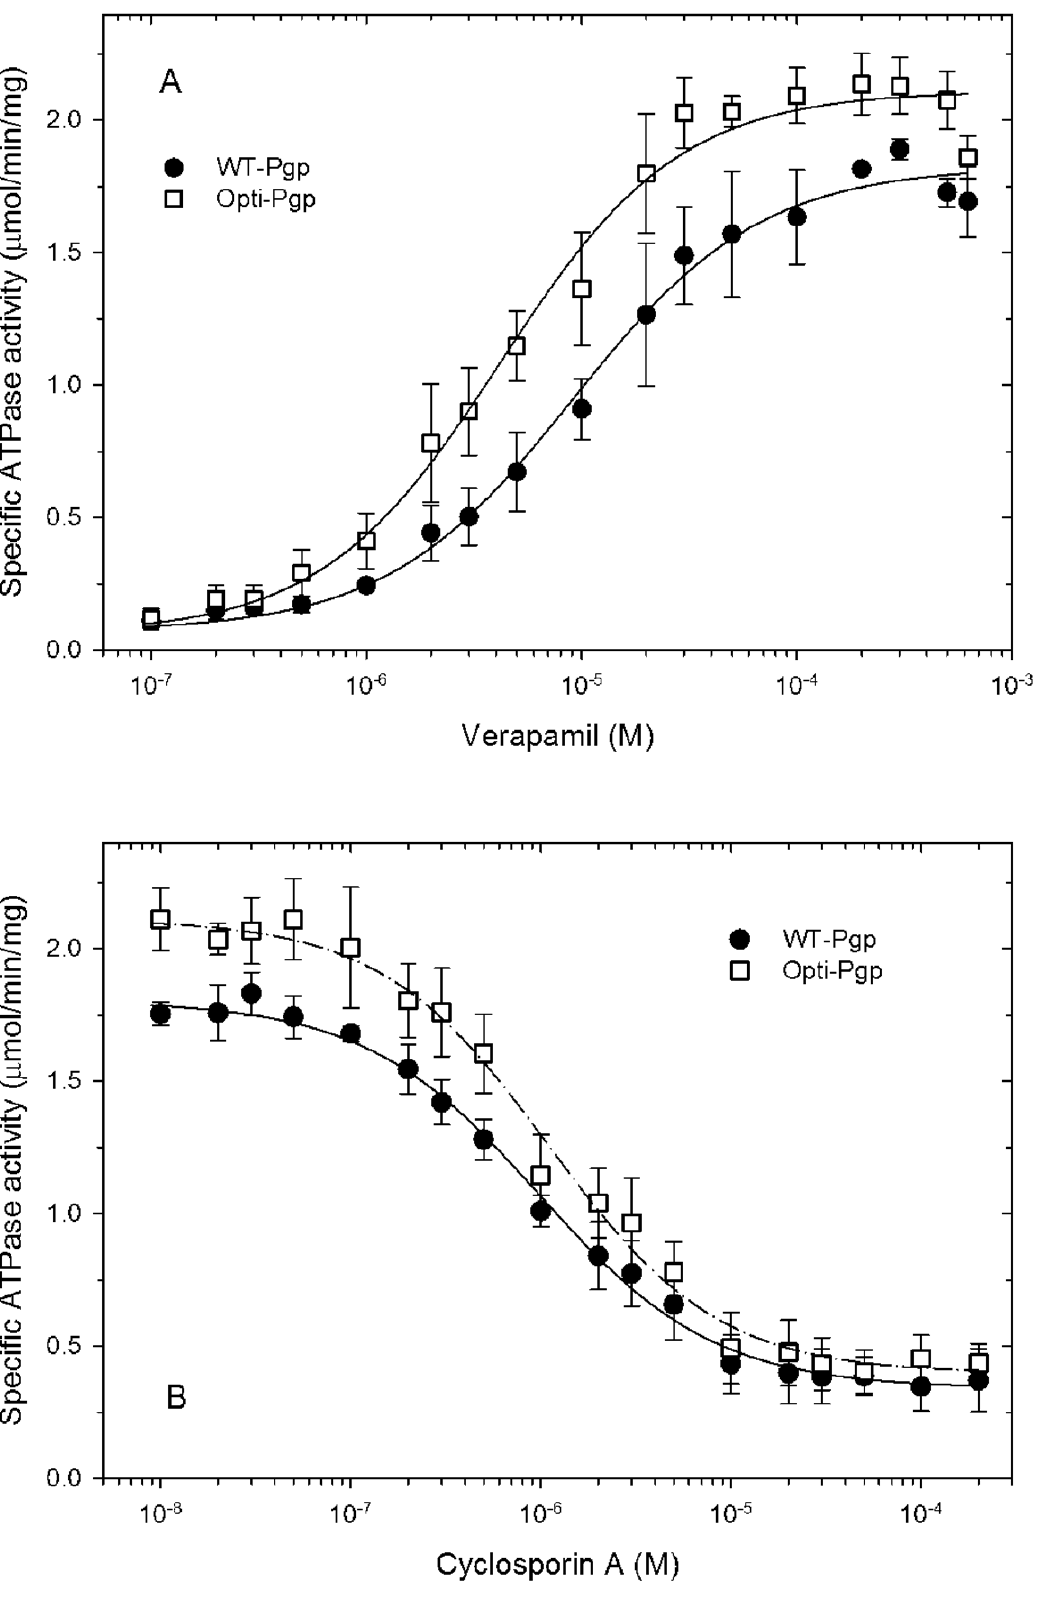
Figure 4. Stimulation and inhibition of ATPase activity. A) The ATPase activity of purified WT- and Opti-Pgp was assayed in the presence of increasing concentrations of verapamil. The solid lines are non-linear regression fits to the equation f=d + (a*x b /(c b + x b )), where d is the activity in the absence of verapamil (basal activity), a is the maximum verapamil-stimulated activity, b is the Hill coefficient, c is the concentration for half-maximal